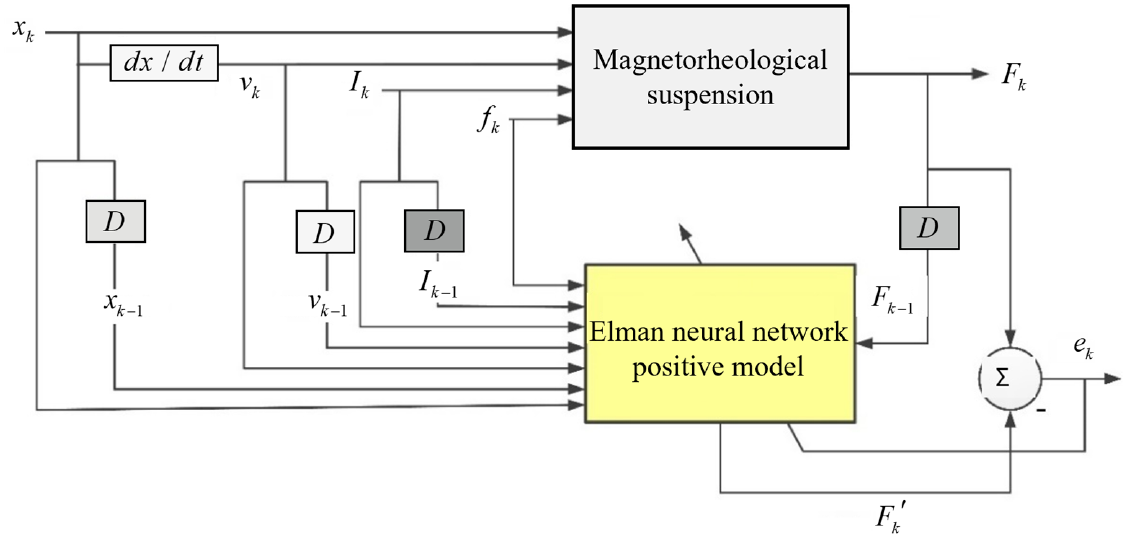
Figure 5. Identification block diagram of suspension positive model.